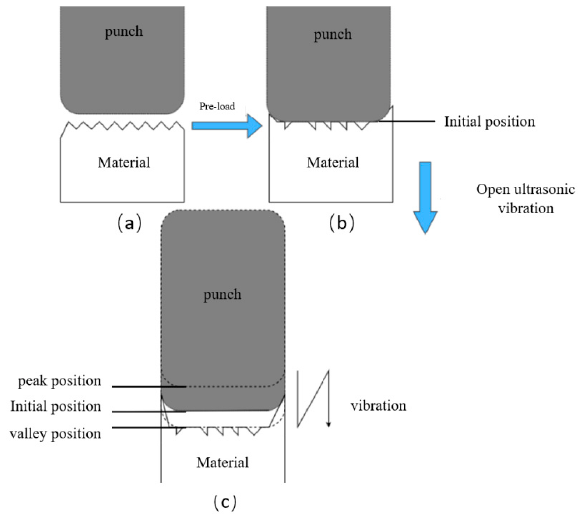
Figure 5. Micro-forging procedure of the punch. ( a ) no-load stage; ( b ) pre-load stage; ( c ) vibration started.